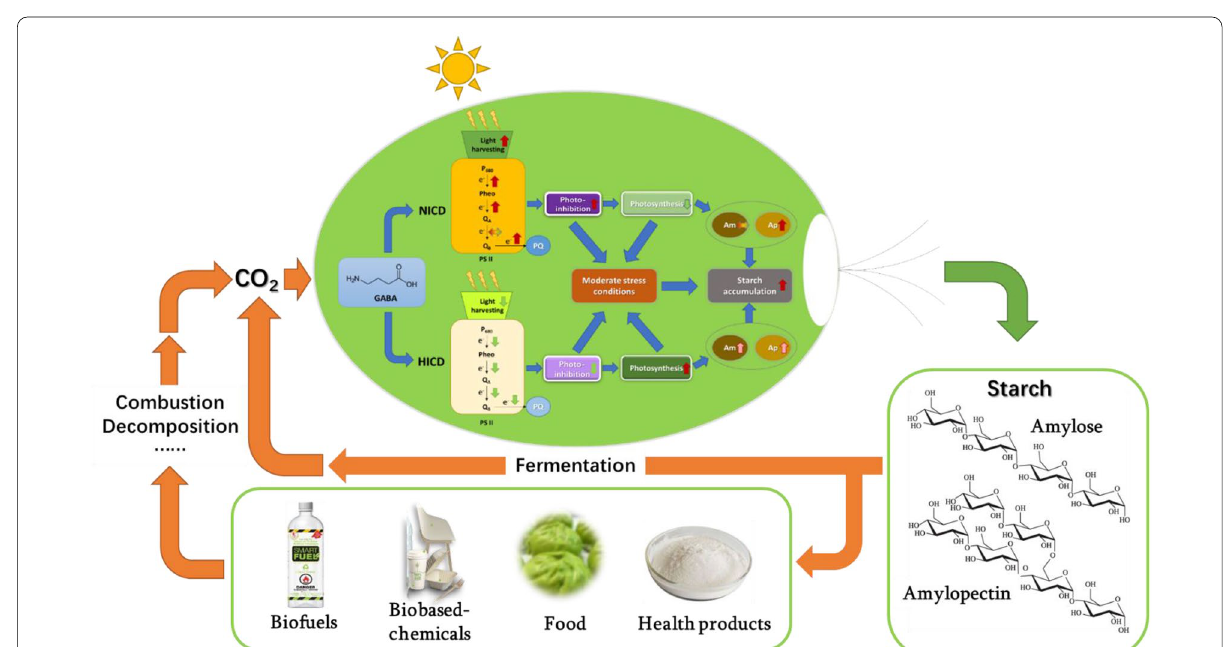
Fig. 8 Proposed circulation of CO 2 to the intermediate molecule starch via microalgae for potentially sustainable